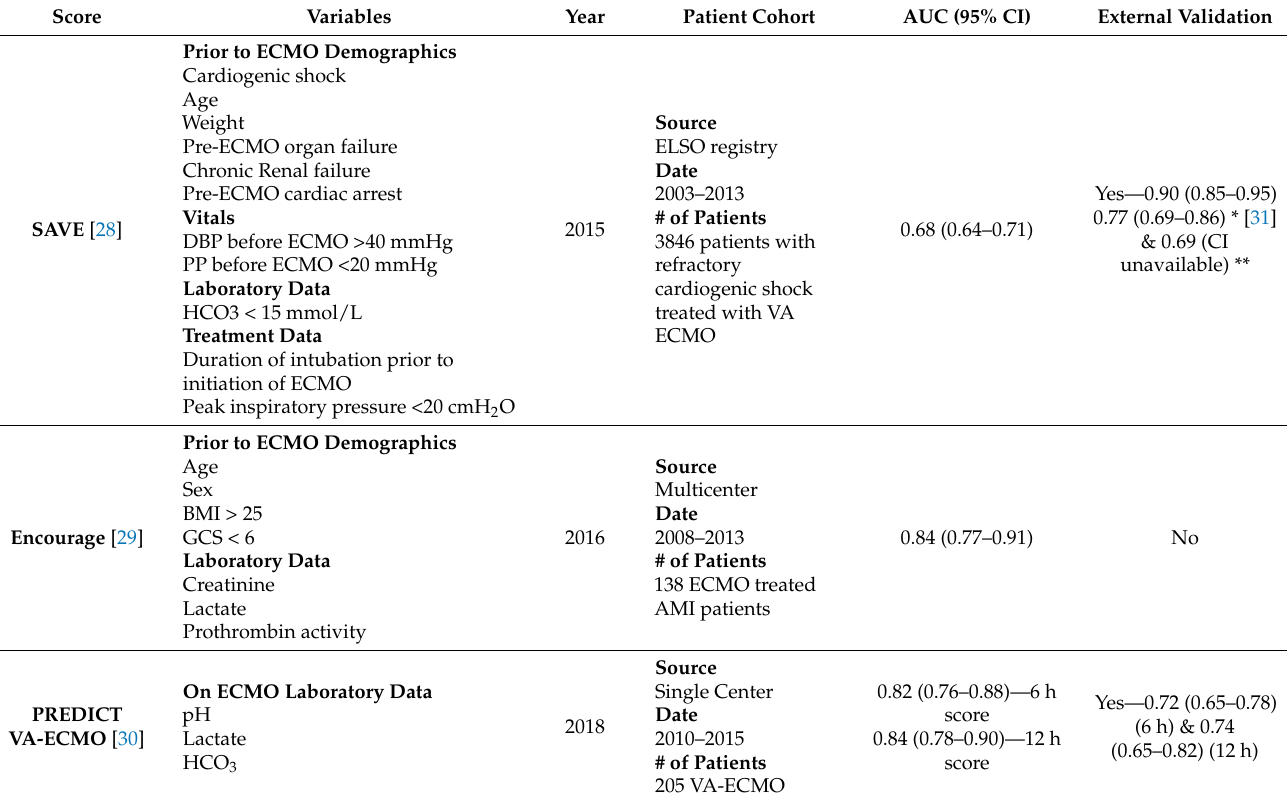
Table 5. Prognostication scores for adult cardiac